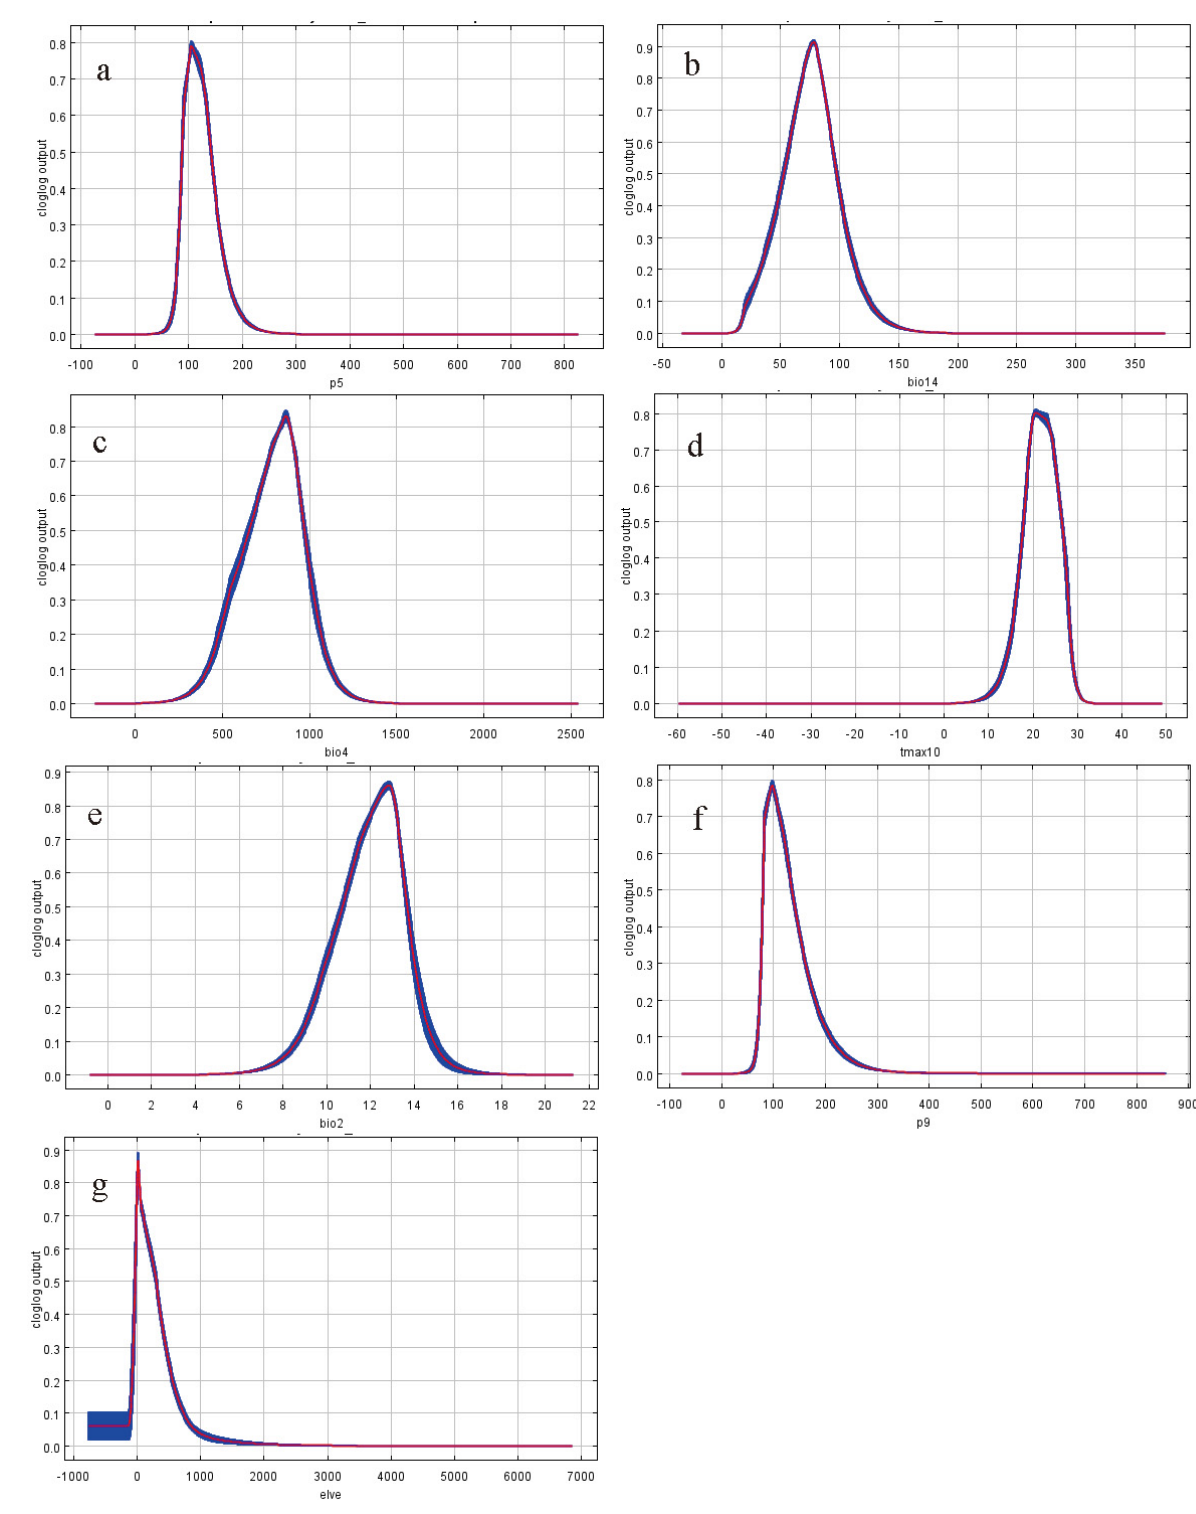
Figure 5. Response curves of environmental variables to the distribution probability of A. americanum : ( a ) Precipitation in May, ( b ) precipitation of the driest month, ( c ) temperature seasonality (standard deviation × 100), ( d ) monthly average maximum temperature in October, ( e ) mean diurnal range (mean of monthly (max temp–min temp)), ( f ) precipitation in September and ( g ) elevation. Curves shown are averages over 20 replicate runs; blue margins show the ± SD calculated over 20 replicates.